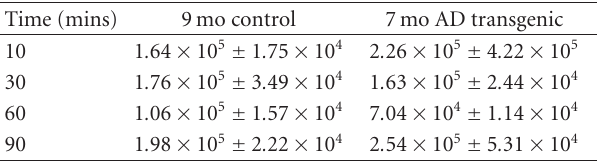
Figure 3: AD transgenic mice injected with 125 ICQ BCA NPs and 125 ICQ (Mice aged 7 mo; 15 minutes post injection).